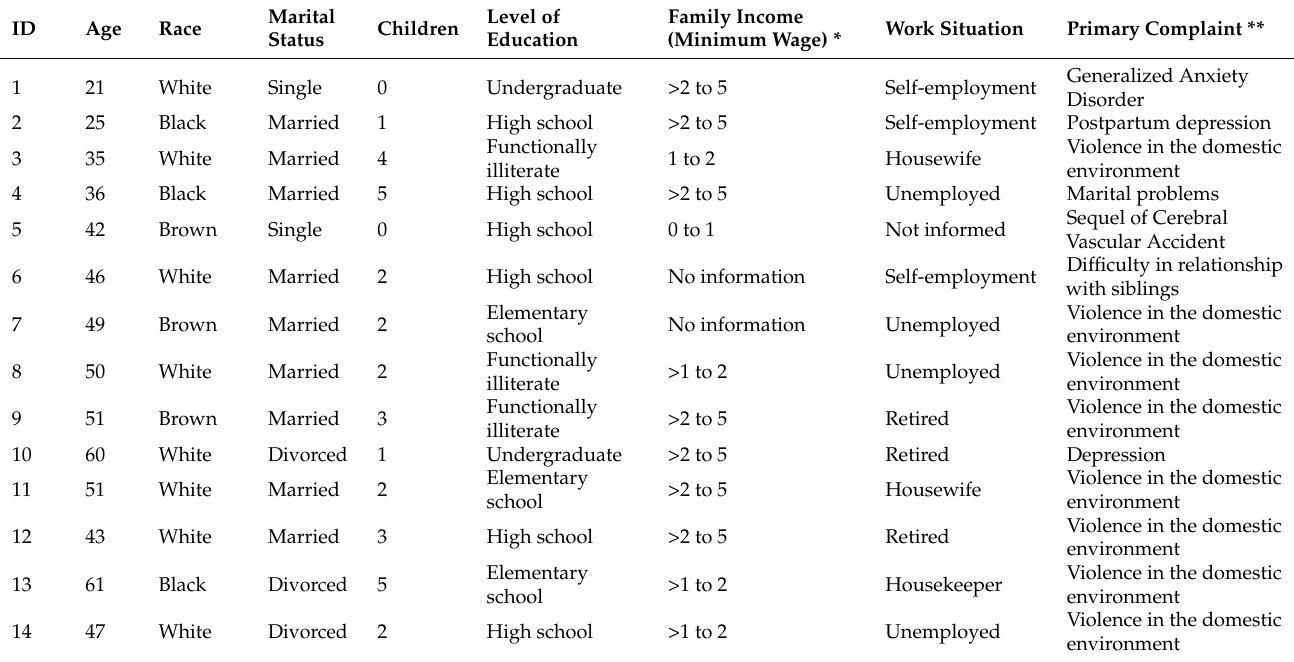
Table 2. Characteristics and main complaints of the